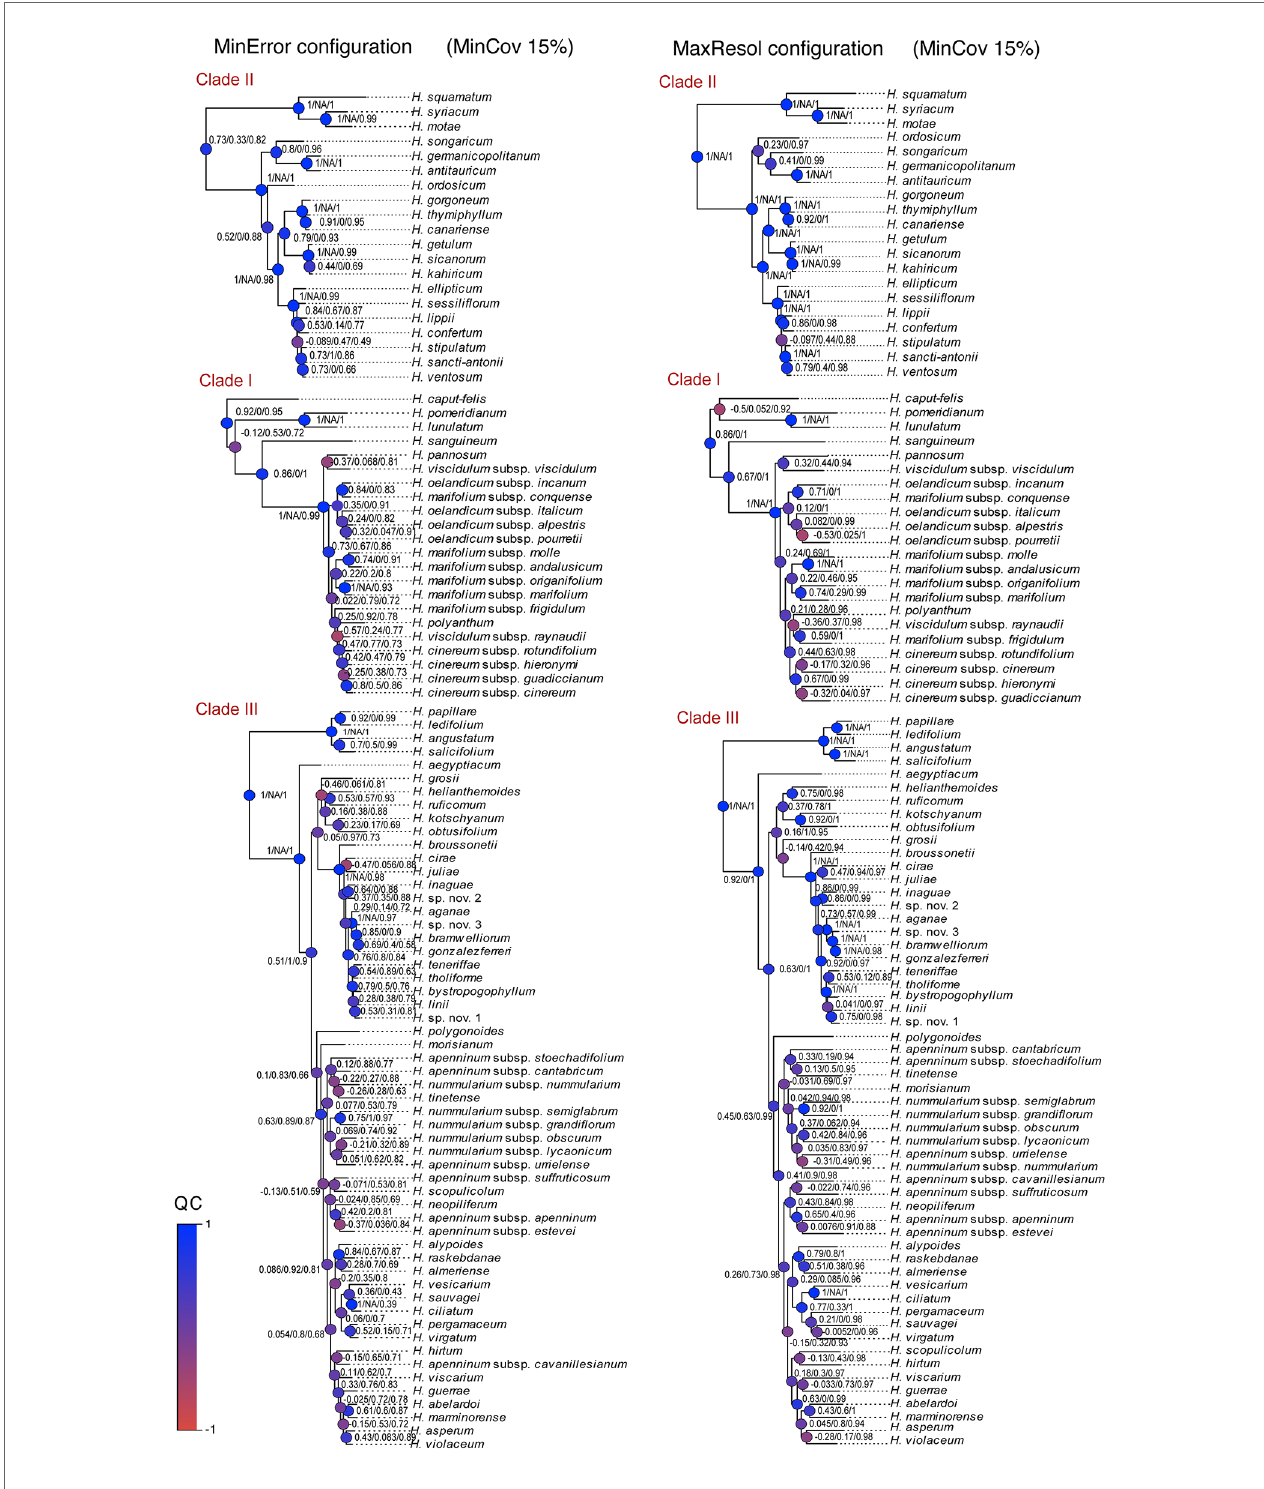
FIGURE 3 | Quartet sampling score for branches of the two Bayesian trees generated under the extreme parameter configurations (MaxResol, maximizing phylogenetic resolution; and MinError, minimizing allele and SNP error rates) under 15% minimum taxon coverage. Scores shown for each branch are in this order, QC/QD/QI. Node are coloured according to QC scores. Clades I, II and III are coincident with those in Aparicio et al., 2017.